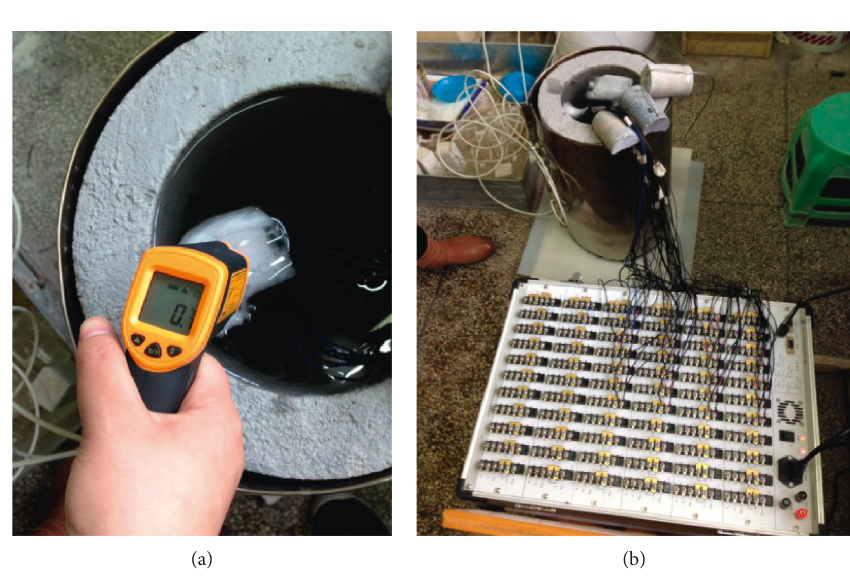
Figure 8: Heating excess cold water and test data